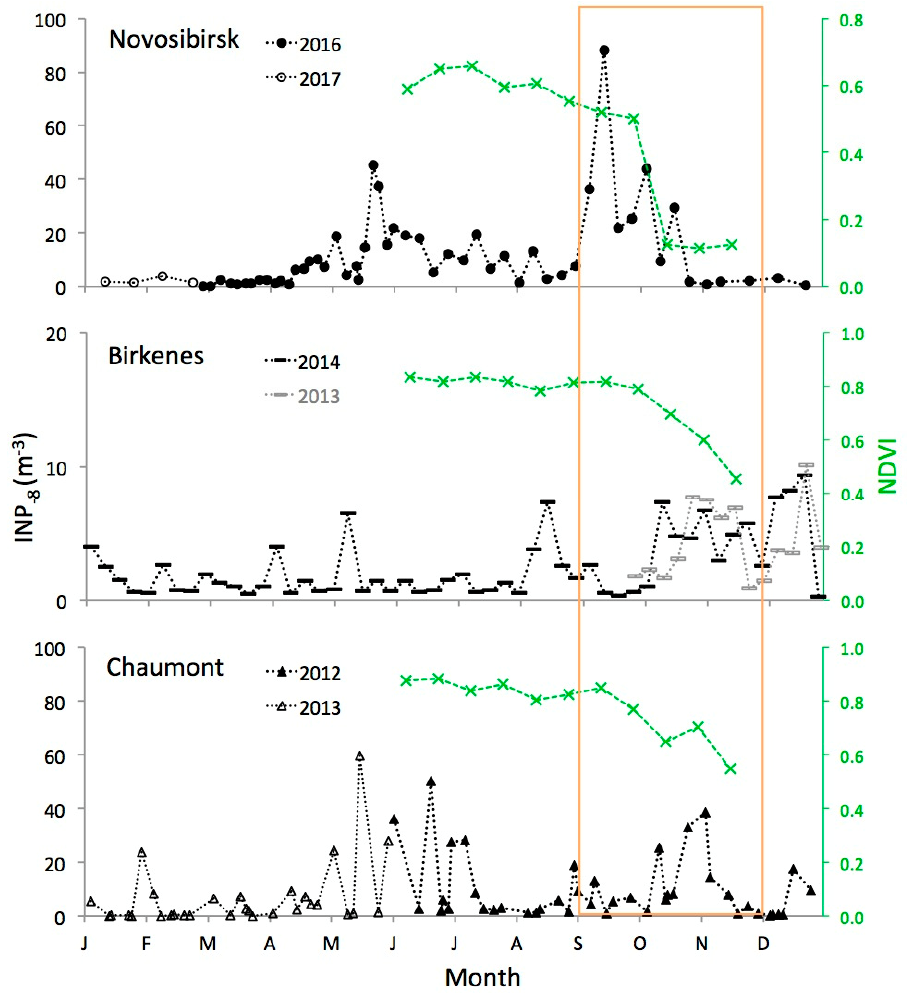
Figure 4. Twelve-months time series of INP − 8 at the locations shown in Figure 1. The series at Novosibirsk and at Chaumont are composites of data from two successive years. At Birkenes, data from the preceeding year is added (in grey) to show the occurrence of the autumn peak in a second year. The area framed in orange indicates the meteorological autumn period (1 September to 30 November). Data from Chaumont and from Birkenes are adapted from previous publications [13,15]. The normalized differential vegetation index (NDVI, green) is indicated for the summer and autumn periods of the same years in which INP − 8 data was obtained.